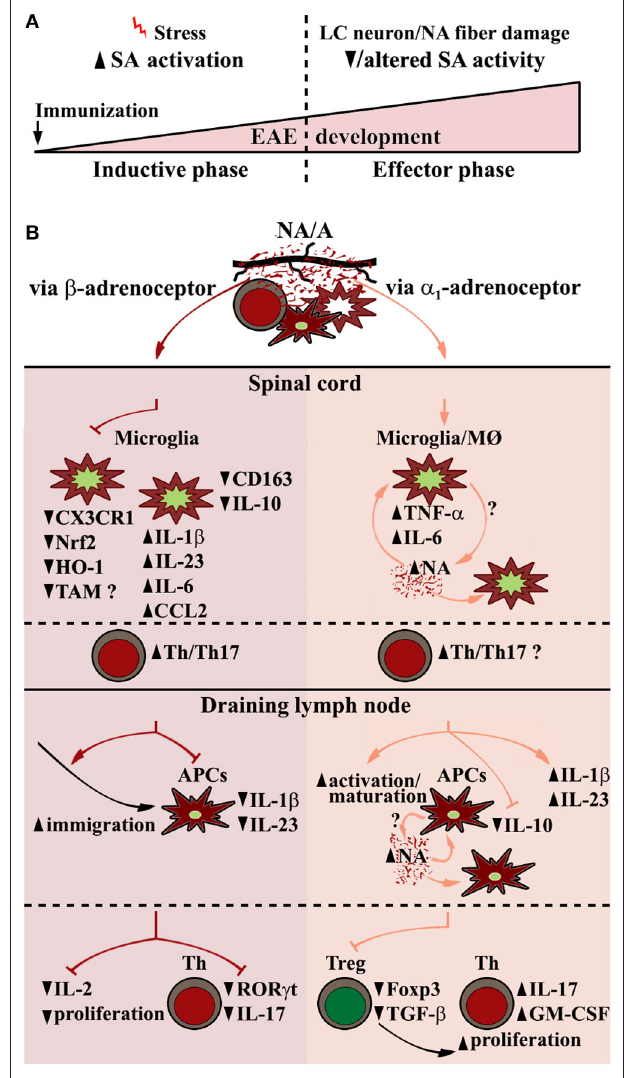
FIGURE 1 | EAE-related alterations in sympathoadrenal system (SA) and putative central and peripheral effects of its key end-point mediators (noradrenaline and adrenaline) contributing to EAE pathogenesis. (A) Biphasic changes in SA over the course of EAE encompass SA overactivation in preclinical EAE stage (premorbid/disease-related stress), followed by its diminished and possibly qualitatively altered activity in clinical stage of the disease partly due to locus coeruleus (LC) neuron damage. (B) (Spinal cord) Central noradrenaline (NA)/adrenaline (A) acting through β -adrenoceptor in early phases of the disease downregulate microglial expression of nuclear factor (erythroid-derived 2)-like 2 (Nrf2), and its key anti-inflammatory downstream target genes, including those encoding heme oxygenase-1 (HO-1), and possibly TAM (Tyro3, Axl, and Mertk) receptors involved in phagocytosis via C-X3-C motif chemokine receptor 1 (CX3CR1)-dependent and CX3CR1-independent mechanisms. This leads to shift toward more proinflammatory microglial phenotype mirrored in increased expression of proinflammatory cytokines/chemokines (e.g., IL-1 β , IL-23, IL-6, CCL2), followed by diminished expression of anti-inflammatory microglial markers (e.g., CD163, IL-10), and consequently, increased infiltration of spinal cord with Th cells, their reactivation/proliferation and differentiation toward pathogenic Th17 cells. (dLN, draining lymph node) NA/A acting through β -adrenoceptor